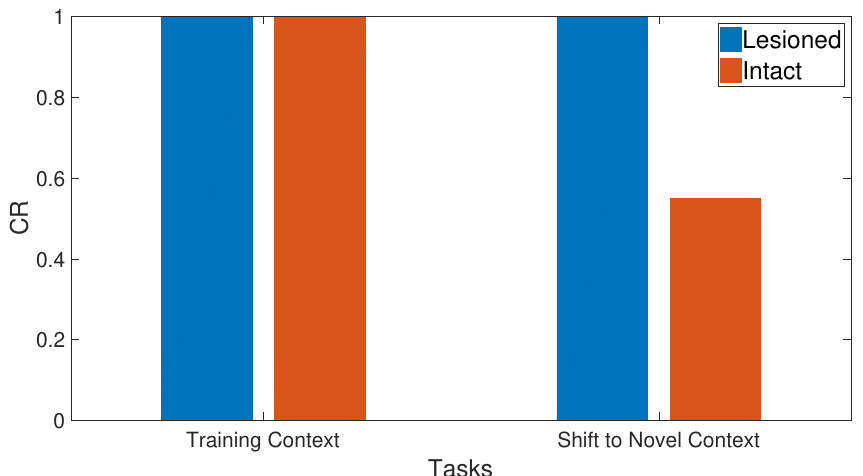
Figure 32. Context sensitivity task for both intact and lesioned systems of the CHCQ model.